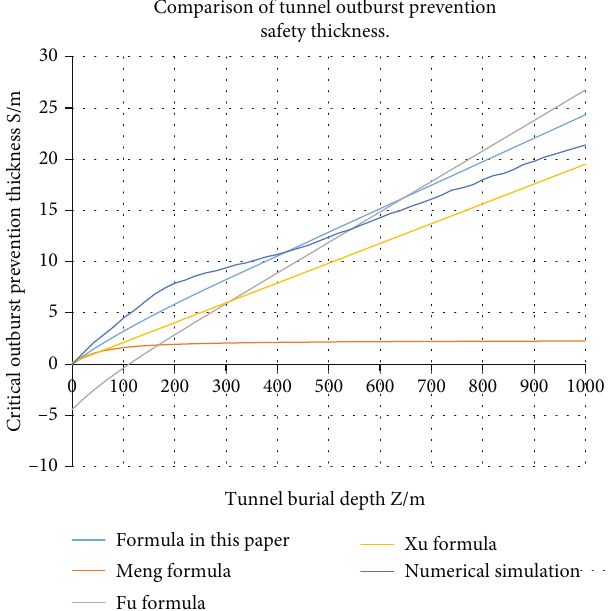
Figure 8: Comparison of tunnel outburst prevention safety